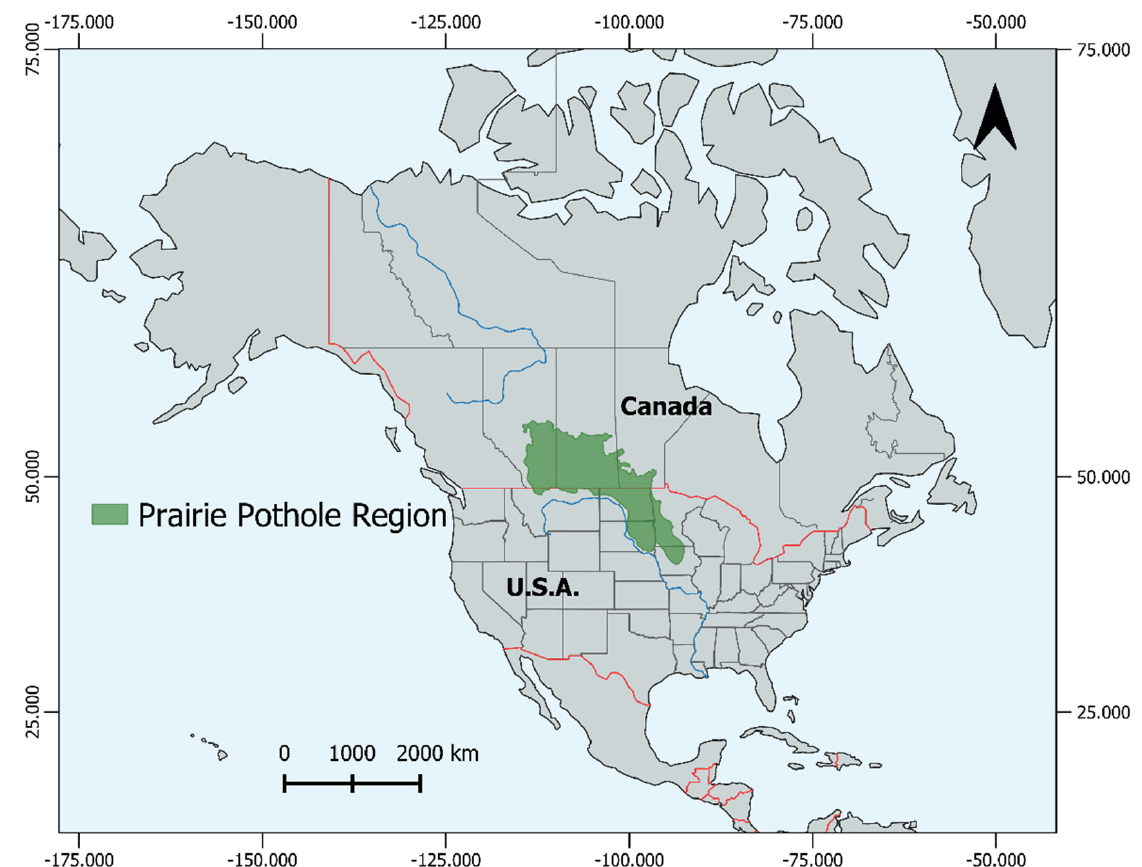
Figure 2. Map of the Prairie Pothole Region of North America. The Prairie Pothole Region boundary is indicated by the green polygon. The red lines indicate country boundaries and the blue lines indicate large rivers. The base map layers used in this figure were obtained from https://www.naturalearthdata.com/ (accessed on 20 September